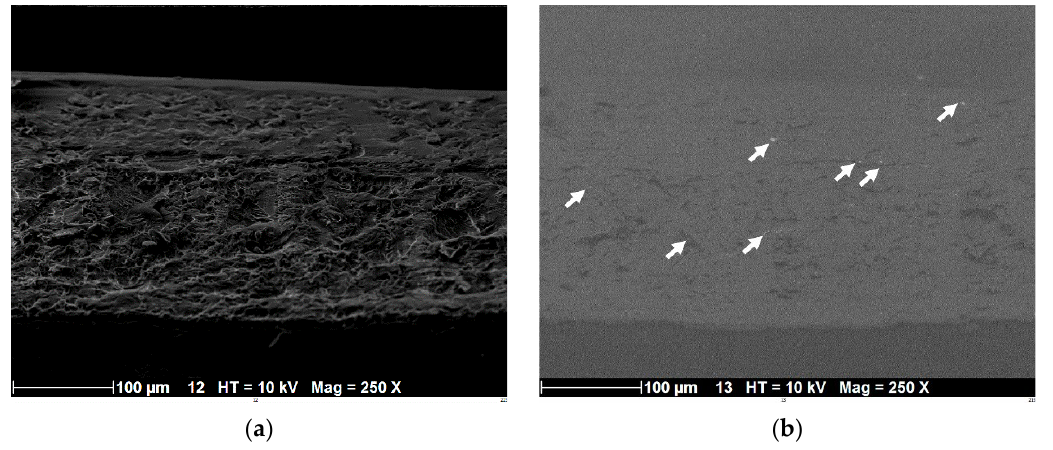
Figure 5. The same PLC cross-section view acquired using: ( a ) secondary electron imaging and ( b ) Backscattered-Electron imaging. The arrows point at the spots of ceramic particles composed of heavy elements.